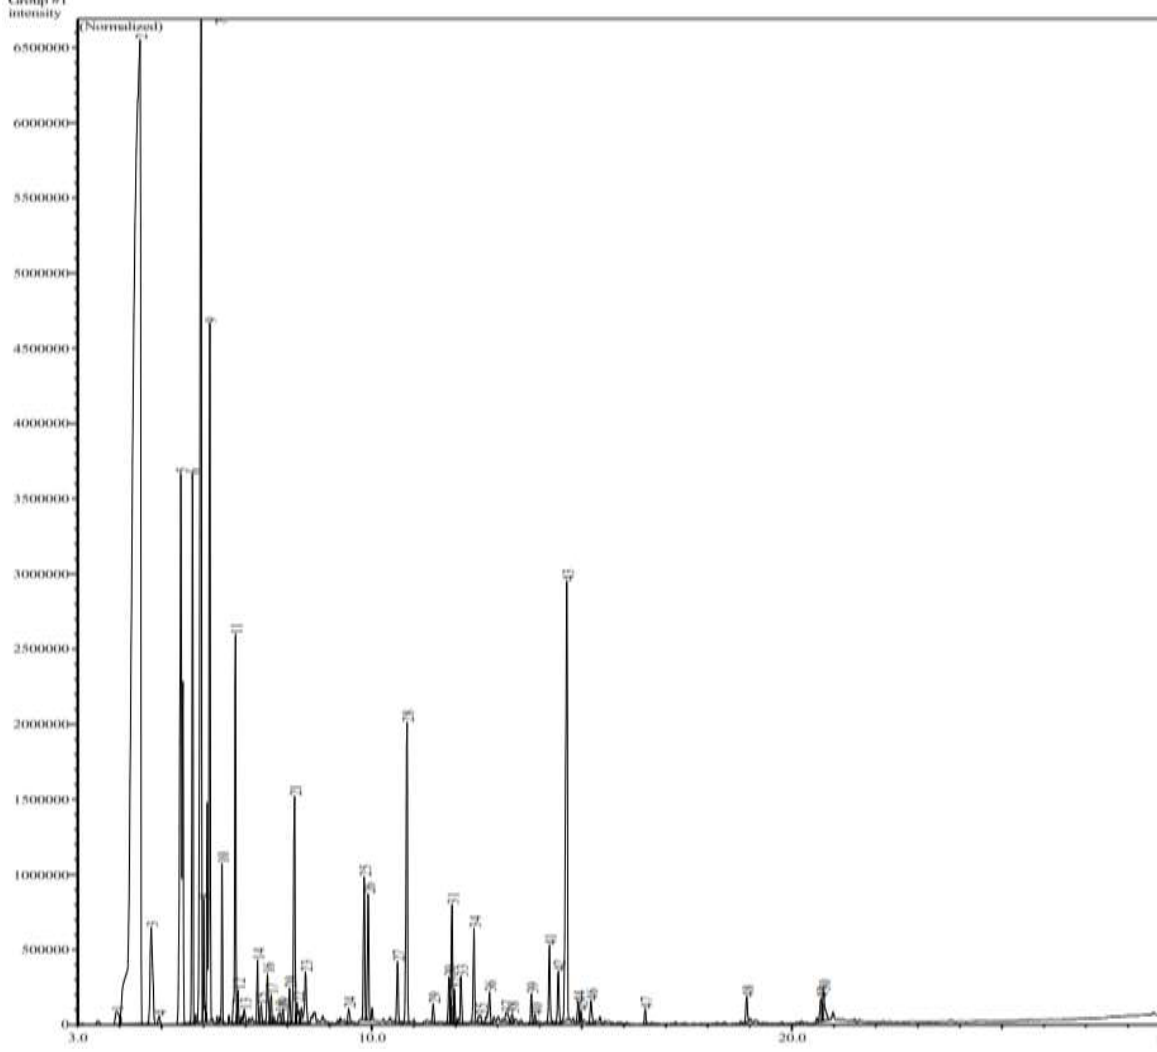
Figure 2. GC-MS chromatogram of essential oil from Iraqi C. sempervirens leaves Table 1. Essential oil composition from leaves of Cupressus sempervirens L. Peak